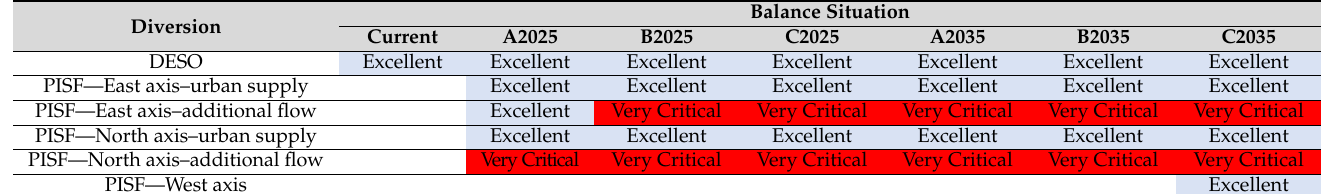
Table 10. Synthesis of surface water balance (Acquanet)—water diversion. See Table 2 for the corresponding classification.